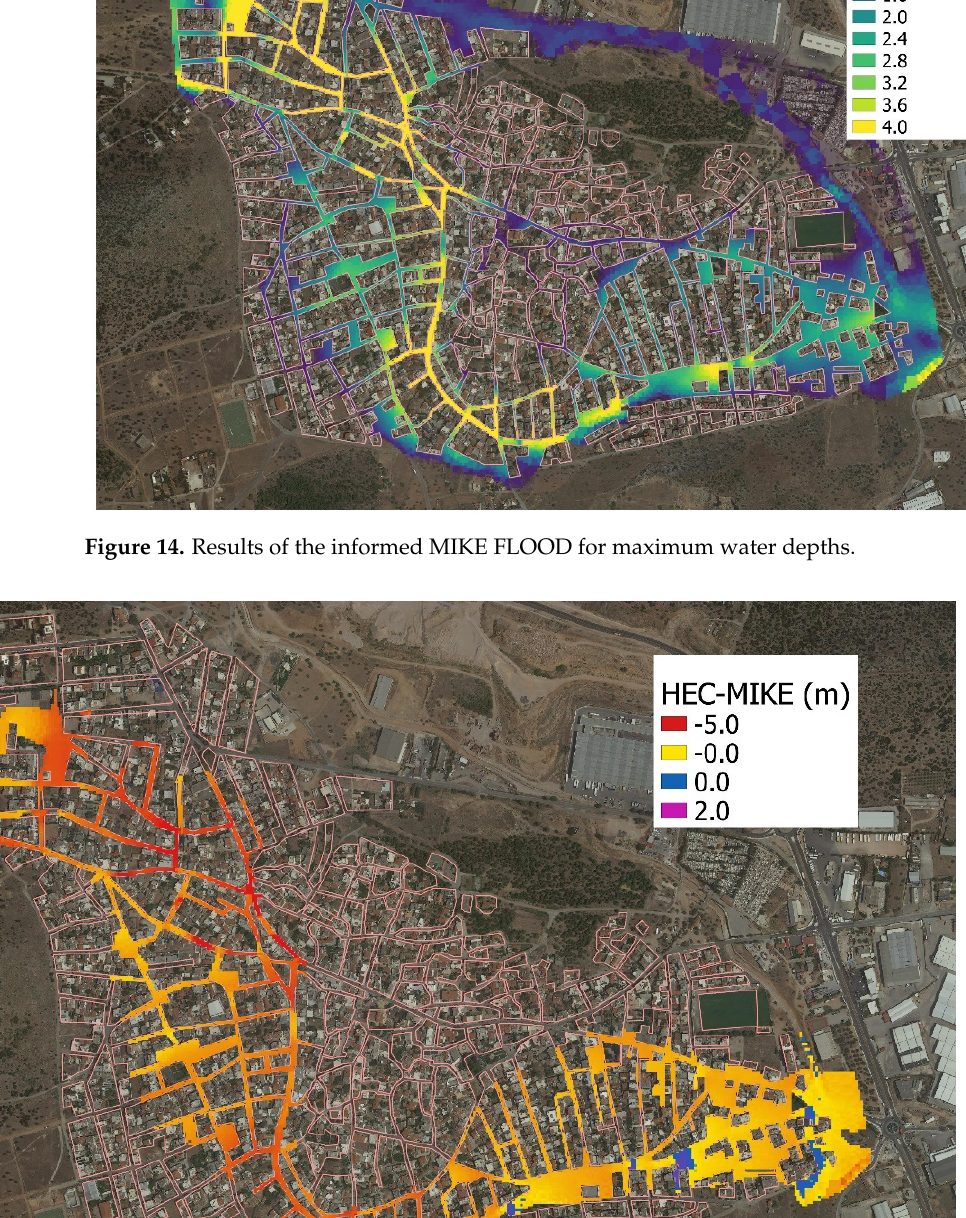
Figure 15. Calibrated HEC-RAS minus informed MIKE FLOOD for maximum water depths.